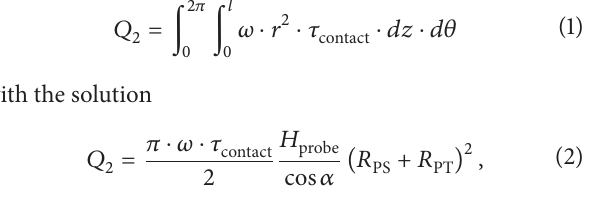
Table 2: Principal mechanical properties of aluminum alloy